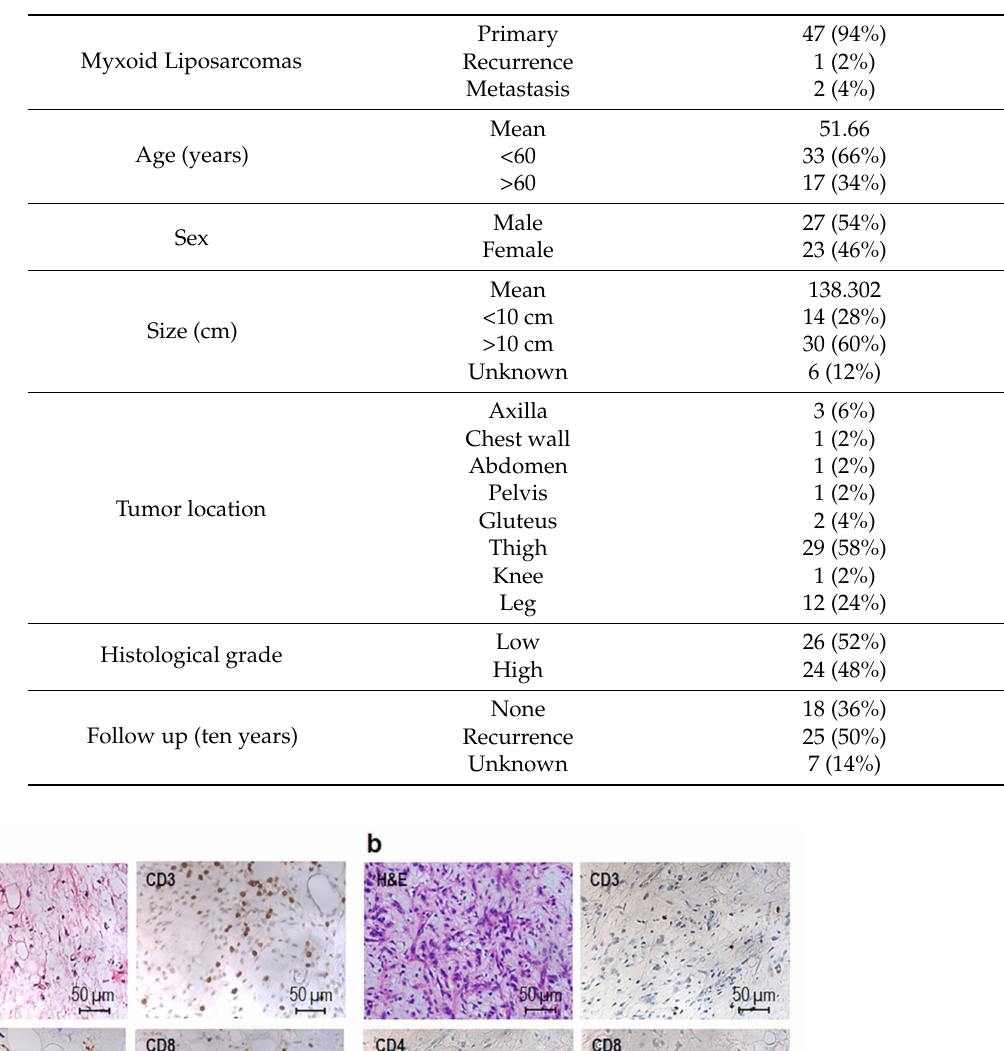
Table 1. Clinical and histologic findings of enrolled MLPS patients.